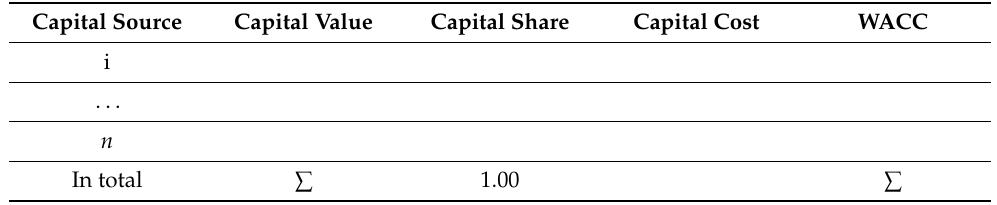
Table 4. Sources of capital, their value, structure and cost as well as the weighted average cost of capital financing the project. Source: designed by